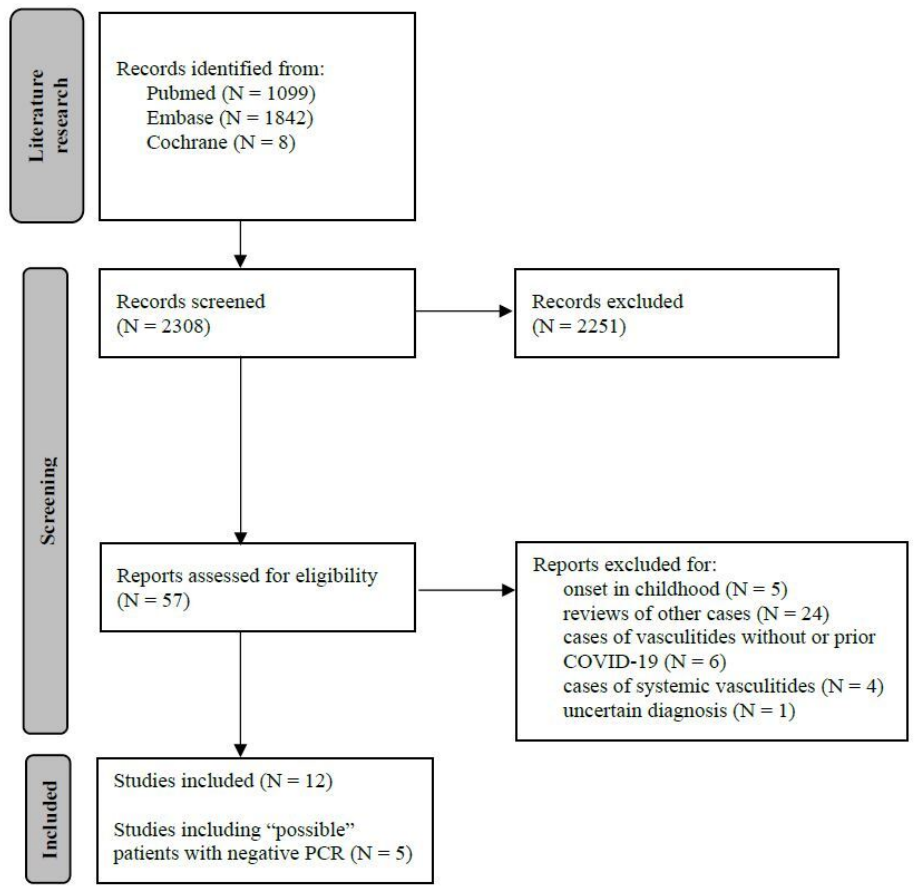
Figure 1. Literature research flow chart. Legend: COVID-19: coronavirus disease 2019, PCR: polymerase chain reaction.